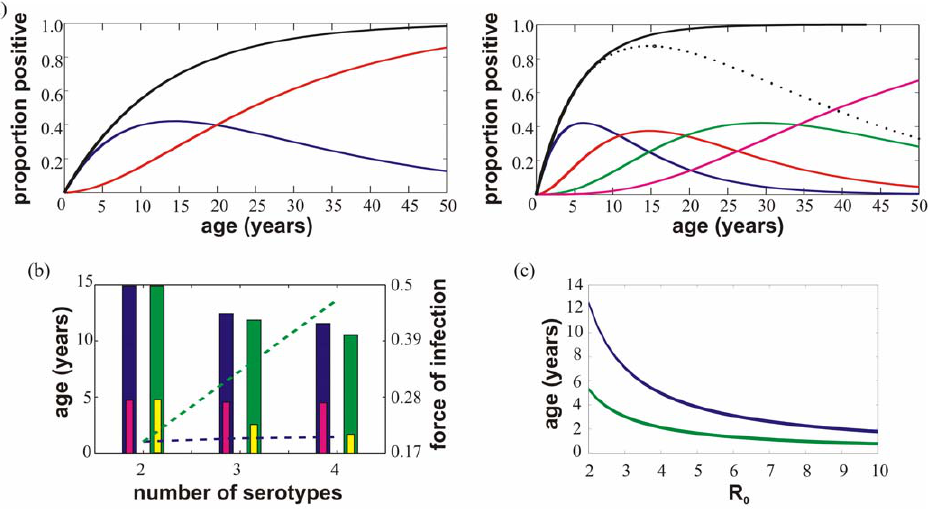
Figure 5. Comparison of age structured dynamics between model (i) and model (ii). (a) The lines show the proportion of the population at each age (for model (i) (top) and model (ii) (bottom)) who have suffered one (solid dark blue line), two (solid red), three (solid green), four (solid magenta) and any (solid black) dengue infections. For model (ii) the proportion of the population that is at risk of disease (defined as having seen 1, 2 or 3 serotypes) is also plotted (dotted black) for comparison to the equivalent in model (i) (solid dark blue). Generally, in model (ii) people are exposed to dengue at an earlier age, experience heterologous infections younger, and take much longer to become completely immune. (b) For model (i) ((ii)), the blue (green) bar shows how the average age of disease (DHF), determined as heterologous infection, changes with the number of serotypes present whilst the small bars show the change in age of first infection. The increase in the total force of infection with the number of serotypes is shown as dotted lines (model (i): blue, and model (ii): green). (c) For model (i) (blue line) and model (ii) (green line) we observe that increasing R 0 acts to decrease the average age of first infection (here estimated as 1/total force of infection) and that for all levels of R 0 this value is significantly lower when allowing for third and fourth infection (model (ii)). Parameter values: w ~ 2 ((a), (b) and (c)) and R 0 ~ 2 (a), R 0 ~ 4